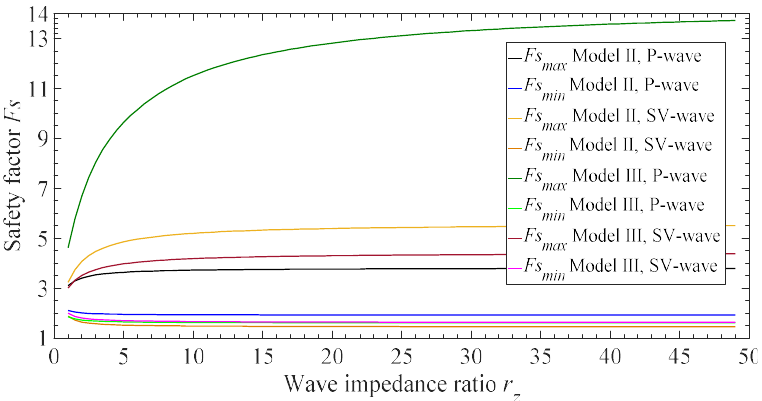
r ( r Z Z  ). Figure 5. Instantaneous safety factor vs. wave impedance ratio r z ( r z = Z B / Z C ) z Bz C r ( r Z Z  ). z Bz C